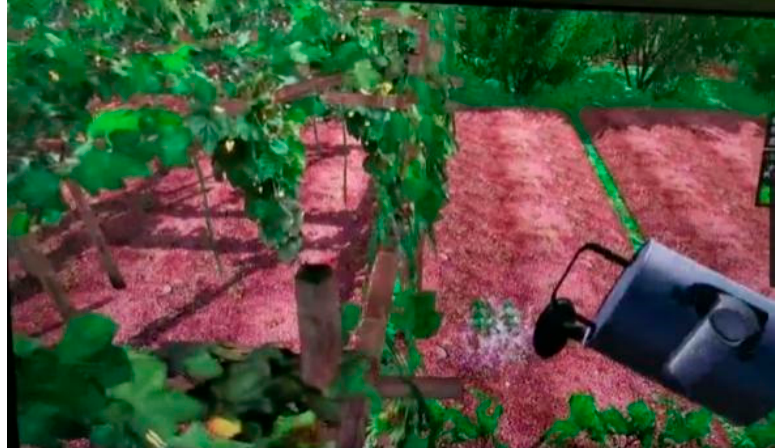
Figure 8. Screenshot of the interactive activity in a restorative garden: watering.